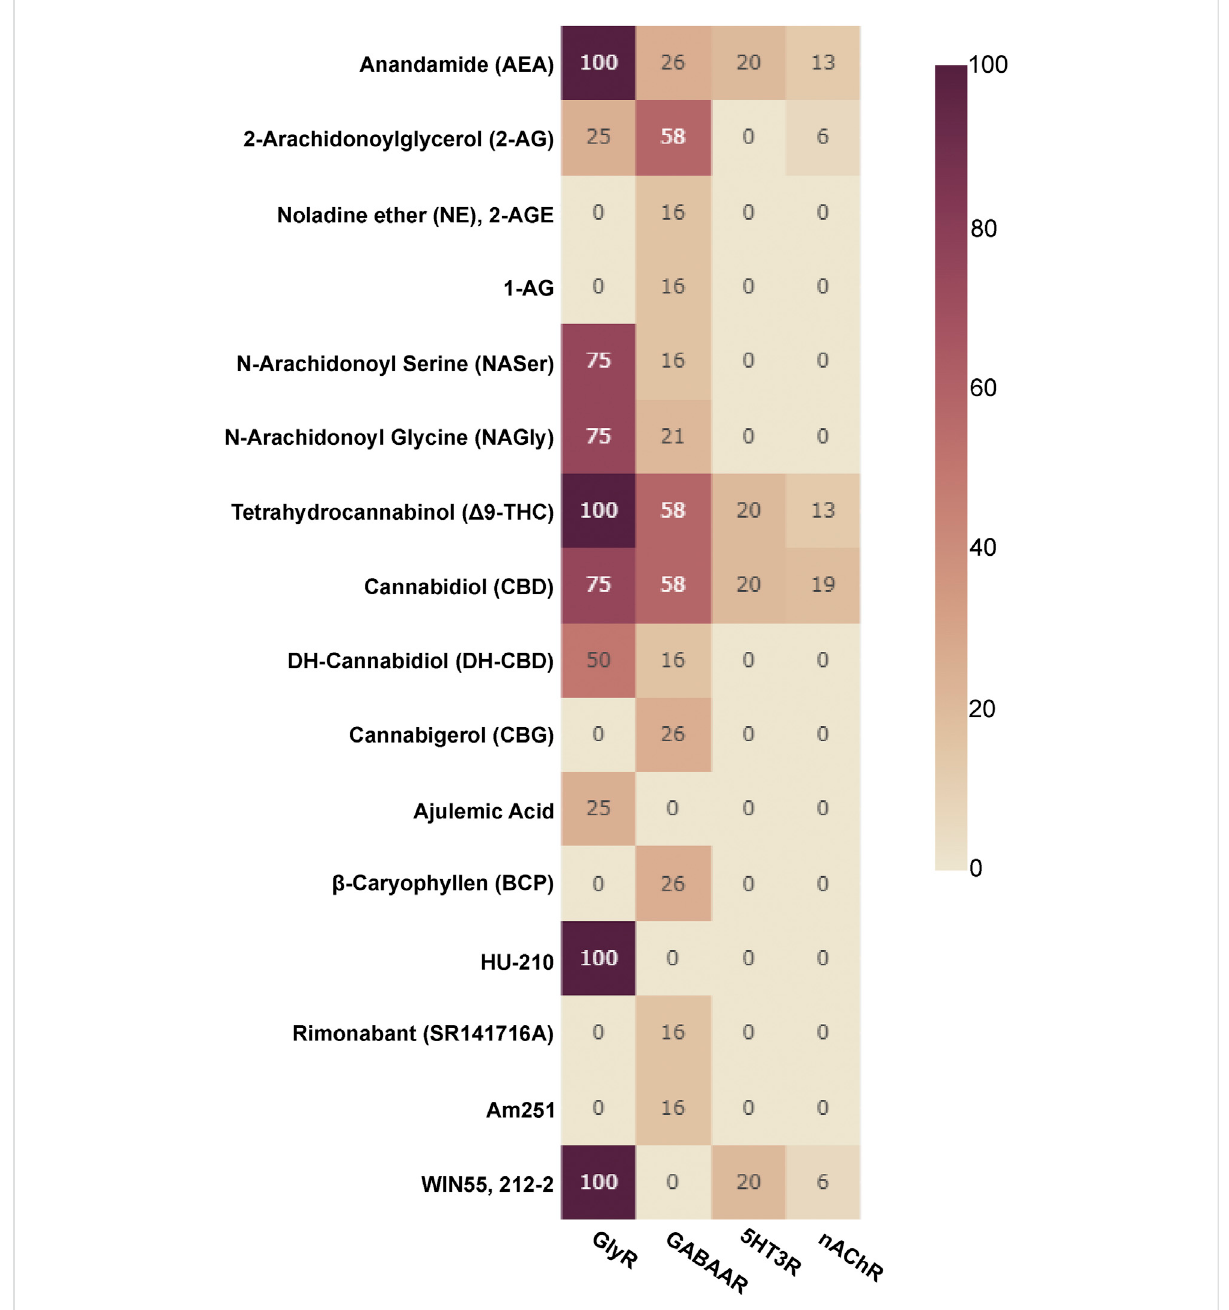
FIGURE 3 CannabinoidstestedonCys-loopreceptors:ThefractionofsubunitsperCys-loopfamilywhichhavebeentestedwiththelistedcannabinoidsis displayed as a heatmap (X of 19 for GABAARs, X of 16 for nAChRs, X of 4 for GlyRs and X of 5 for 5HT3Rs, no data is available for